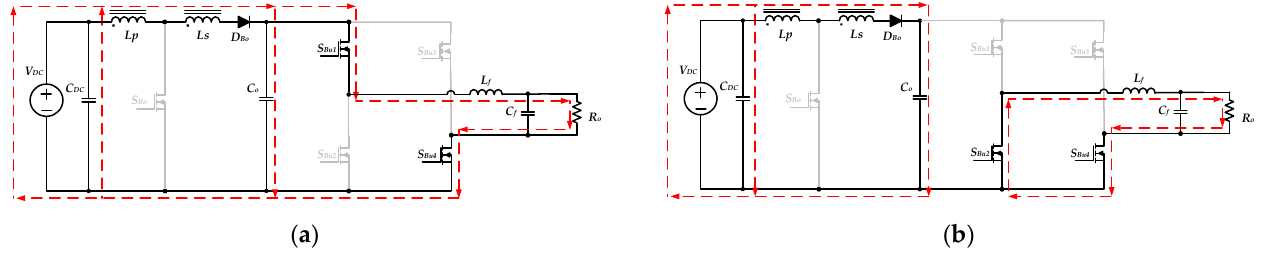
Figure 6. The equivalent circuits of the inverter operating in step-down mode during the positive half-cycle: ( a ) S Bu 1 on, and S Bu 2 off; ( b ) S Bu 1 off, and S Bu 2 on.